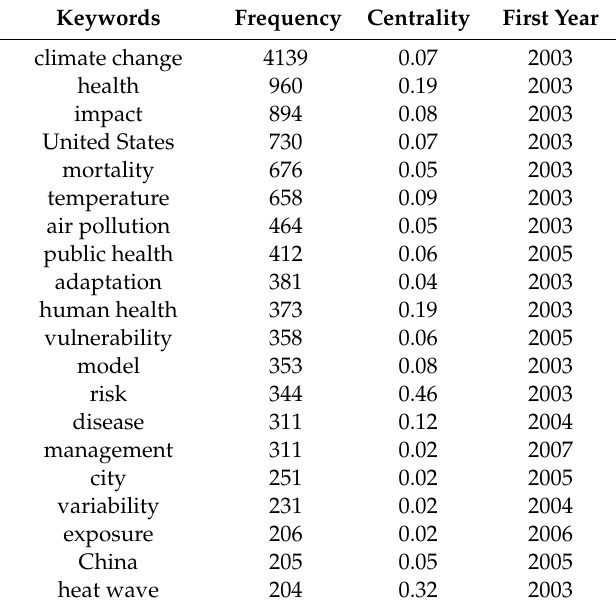
Table 6. Co-occurrence frequency of the top 20 keywords.